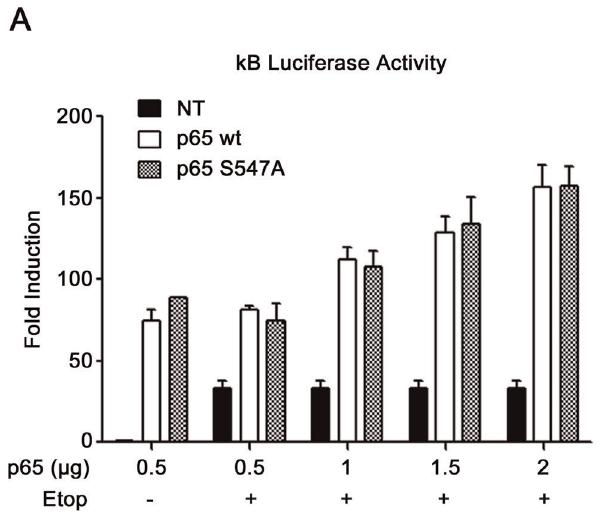
Figure 2. No impact of p65 Ser 547 phosphorylation on global NF- k B transcriptional activity. ( A ) HEK-293 cells were transfected with k B Luciferase plasmid and with increasing amount of either wt or S547A mutated p65. Twenty-four hours later the cells were treated for 8 h with etoposide or left untreated. NT, non transfected.